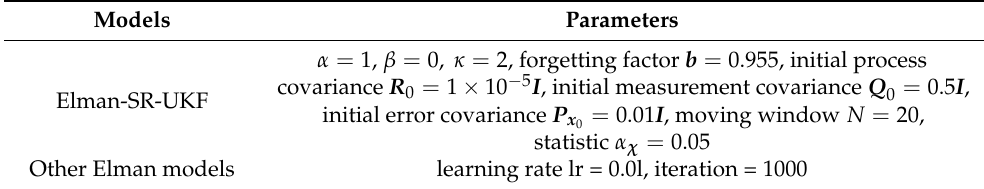
Table 2. Parameters definition of the